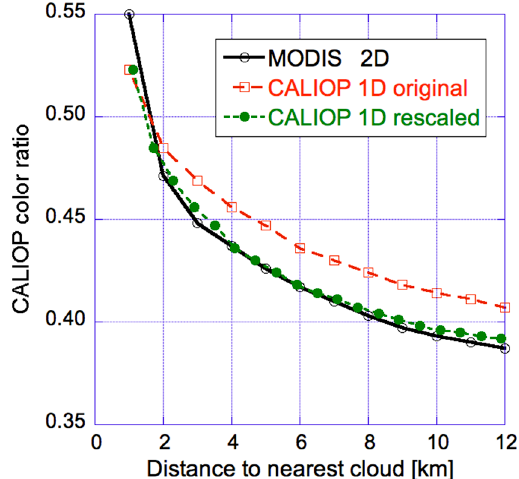
Figure 8. Median CALIOP color ratio (integrated up to 3 km altitude) near clouds detected by the 2-D MODIS cloud mask (black empty circles), by the 1-D CALIOP cloud mask (red empty squares) and if the distance to clouds detected by the 1-D CALIOP mask are rescaled to estimate the effect of clouds outside the lidar track (green full circles). The plot is for a global dataset of daytime satellite data over all oceans free of sea ice between latitudes 60 ◦ S and 60 ◦ N. The figure is based on Figure 5 of [48].